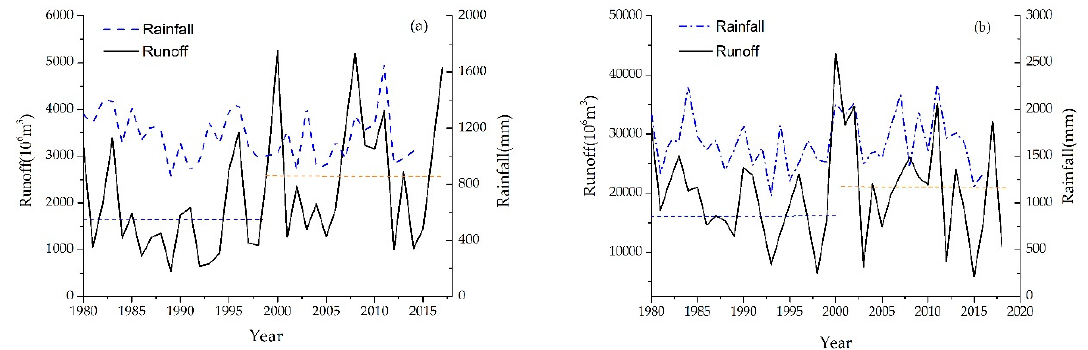
Figure 4. Variations of annual runo ff and rainfall at CHUMPHON (CH) ( a ) and UBON (UB) ( b ) stations. Table 2. Variation characteristics of runo ff at CHUMPHON (CH) and UBON (UB) stations in the Mun River basin.